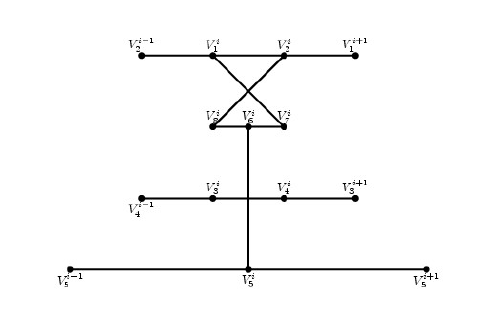
Figure 1. Used in the construction of Goldberg